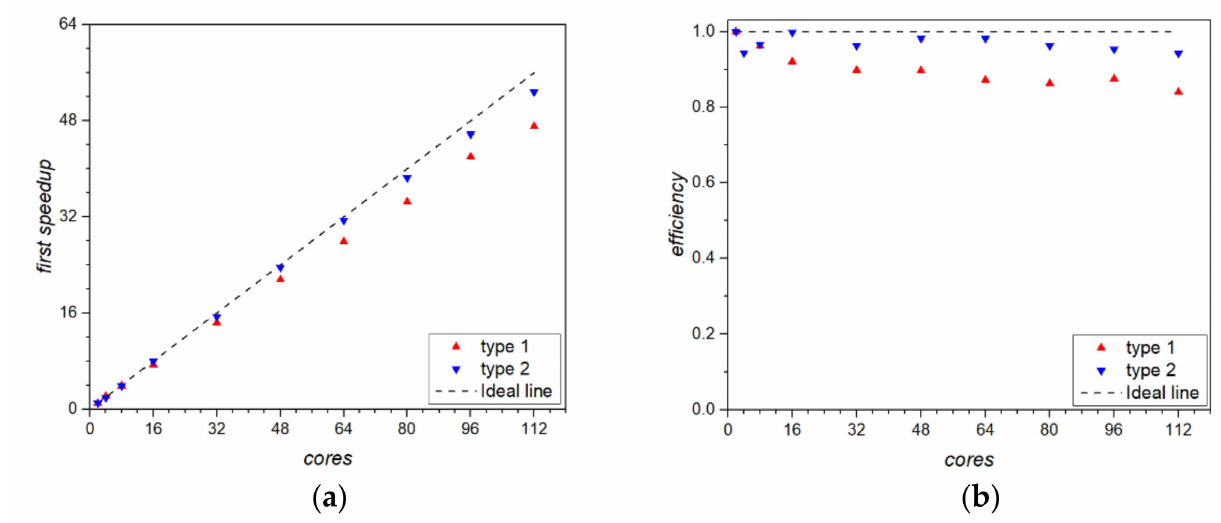
Figure 10. The first parallel speedup and efficiency: ( a ) Speedup; ( b )